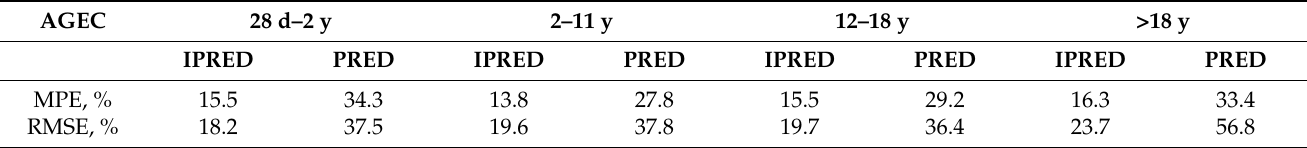
Table 3. Summary of precision and bias of the final model in the external evaluation dataset.